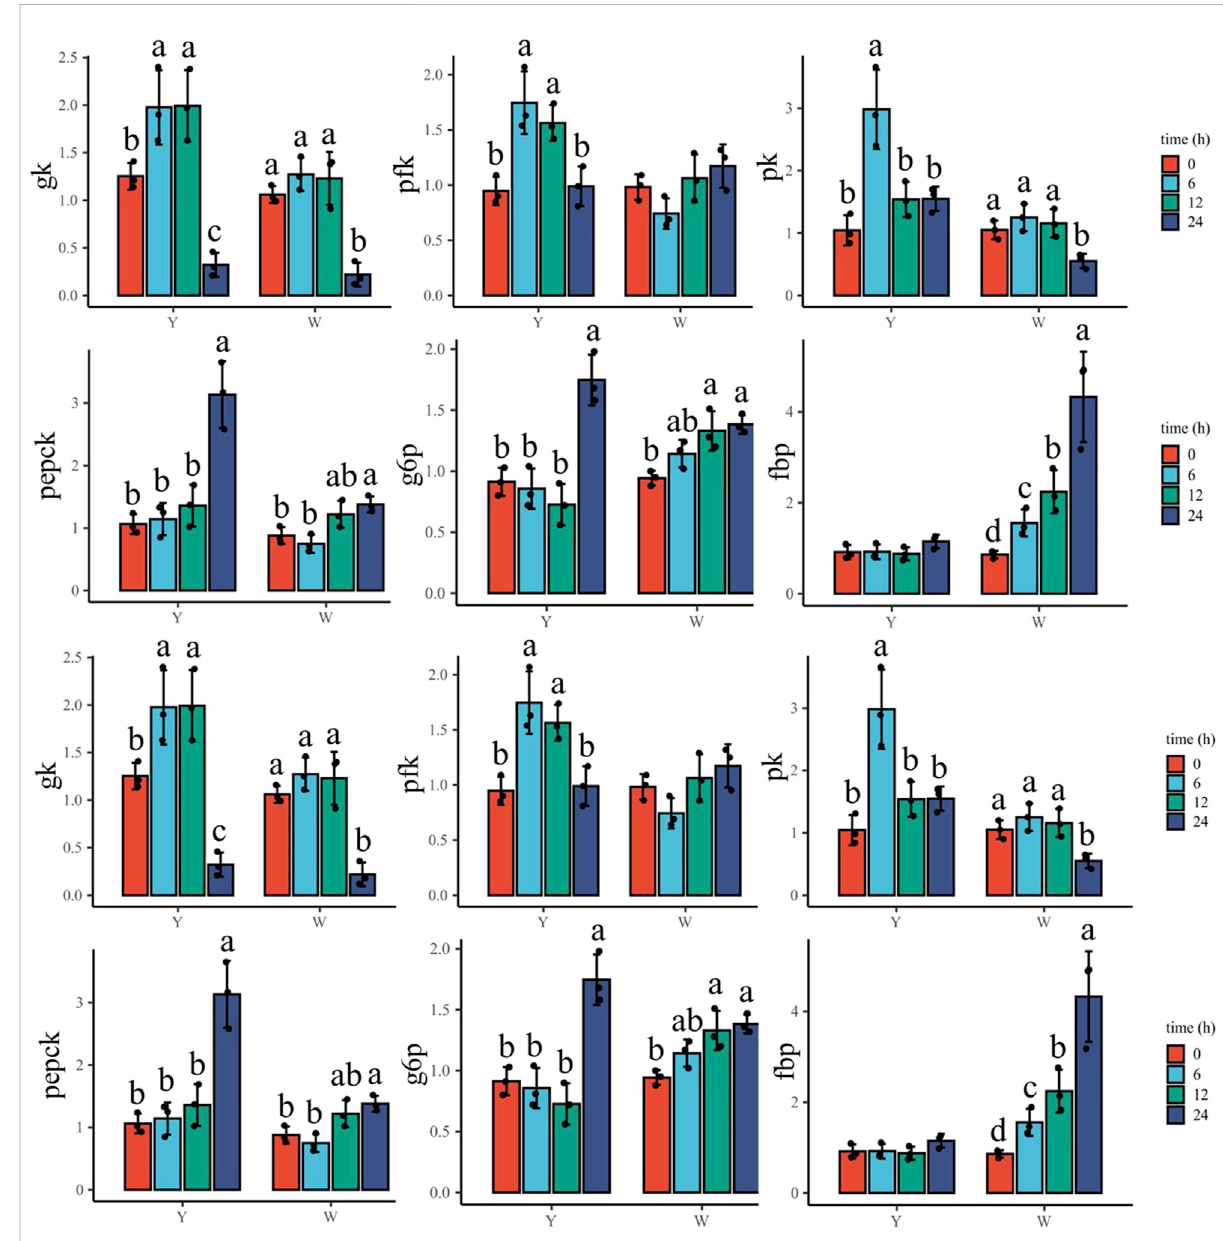
FIGURE 3 Expression of hepatic genes involved in glucose overload response. Data are expressed as mean + SD ( n = 12). Different letters indicate signi fi cant differences ( p < 0.05). gk , glucokinase; pfk : phosphofructokinase; pk , pyruvate kinase; pepck , phosphoenolpyruvate carboxykinase; g6p , glucose-6-phosphatase; fbp , fructose bisphosphatase; fas , fatty acid synthetase; lxr-1 , liver X receptor-1; srebp , sterol regulatory element-binding protein; icdh-1 , isocitrate dehydrogenase-1; kgdc , alpha-ketoglutarate dehydrogenase complex; gs , glycogen